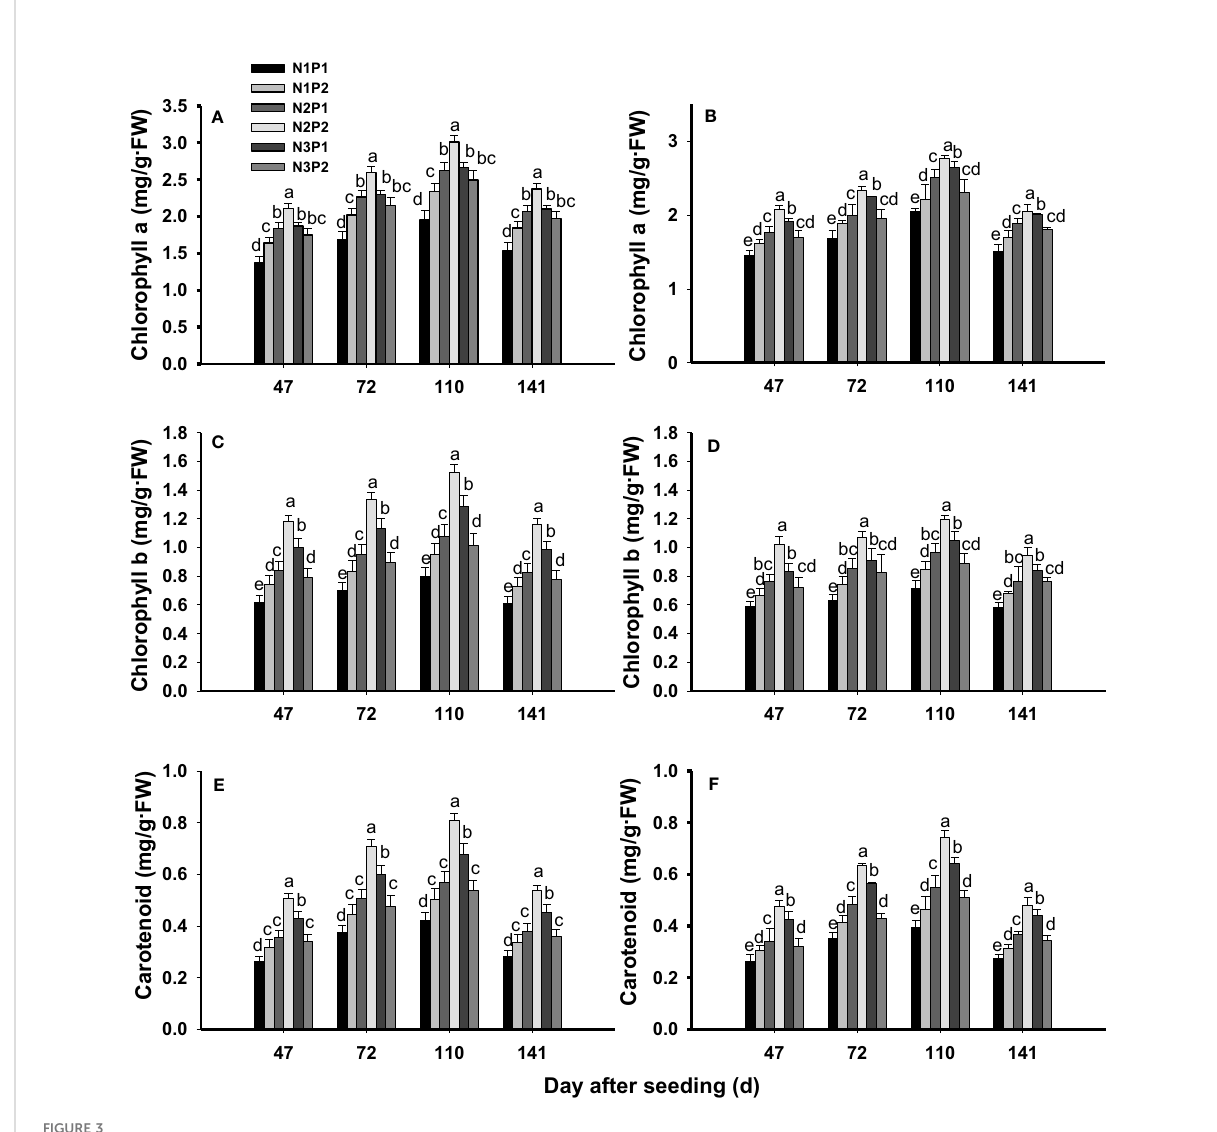
FIGURE 3 Effects of different nitrogen and phosphorus combinations on contents of chlorophyll a, chlorophyll b and carotenoid of sesbania pea at different growth stages. Different lowercase letters indicate signi fi cant differences between different treatments at same growth stage at P< 0.05 level. (A, C, E) : 2020; (B, D, F) :